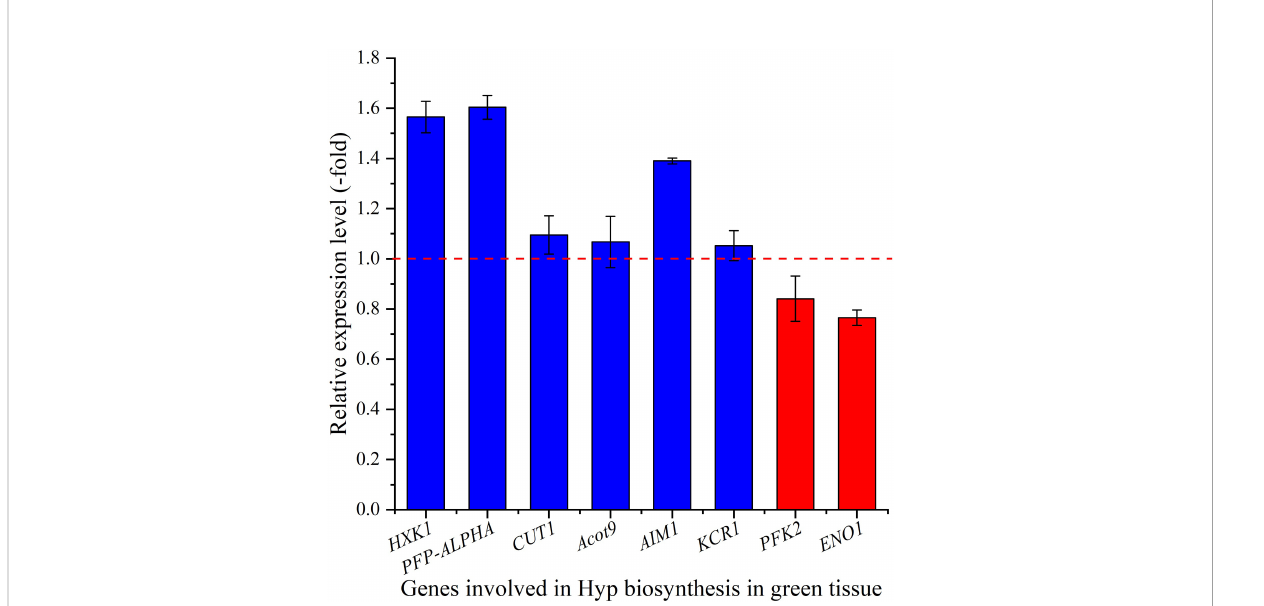
FIGURE 7 The expression level of genes involved in Hyp biosynthesis in green tissue for seedlings grown at 15 versus 22°C, as determined by qRT-PCR (n=3). Column highlighted in blue represents gene up-regulation and red represents gene down-regulation. The red dotted line in the image differentiates up-regulation (>1) and down-regulation (<1) at 15°C compared with 22°C (Control),